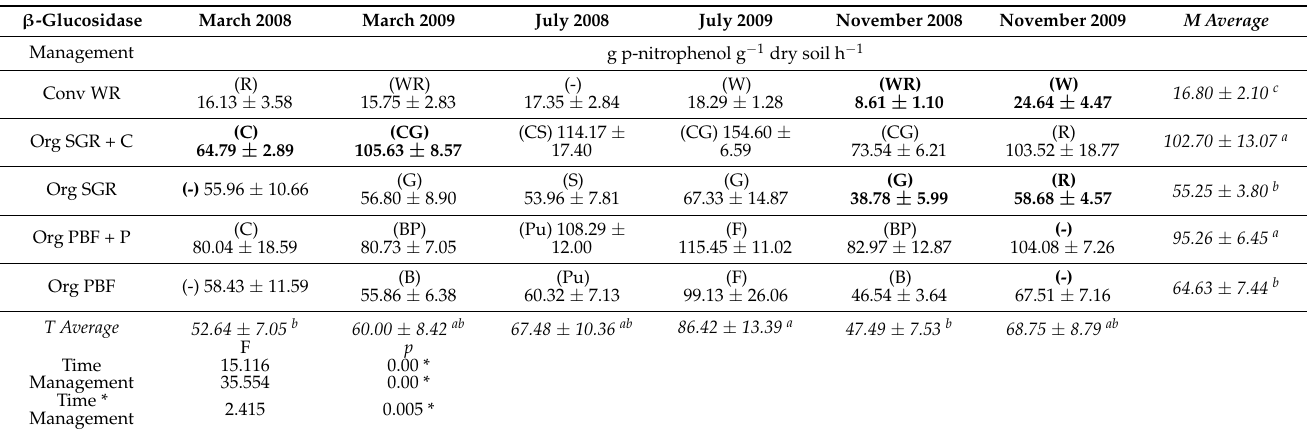
Table 12. β -Glucosidase enzymatic activity in soil.